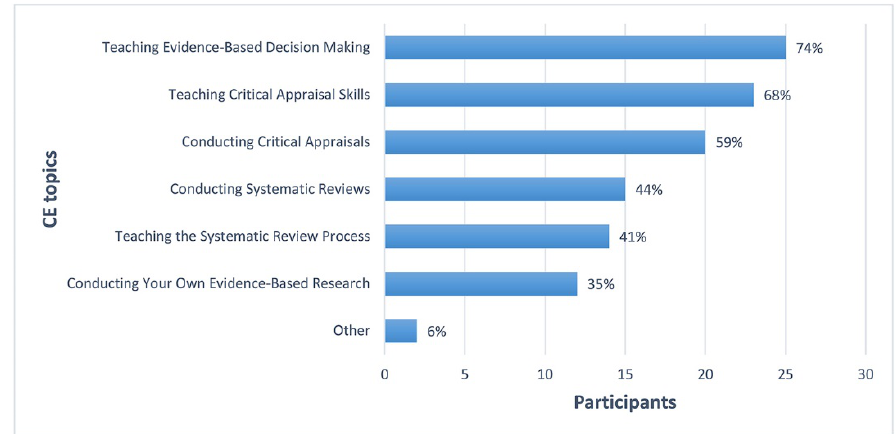
Figure 3 Topics of interest for future continuing education (CE)